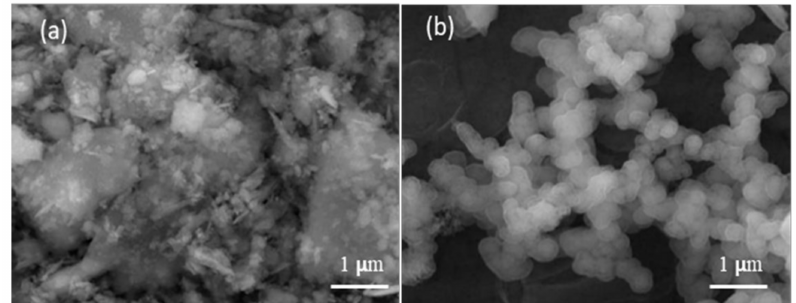
Figure 8. SEM images of electrodeposited layers on SS at − 1.4 V: ( a ) 3000 and ( b ) 6000 s.